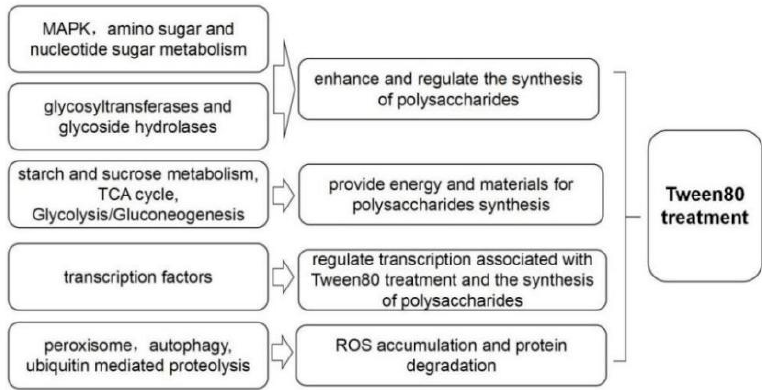
Figure 5. A model of the enhanced effect of Tween80 on exopolysaccharide